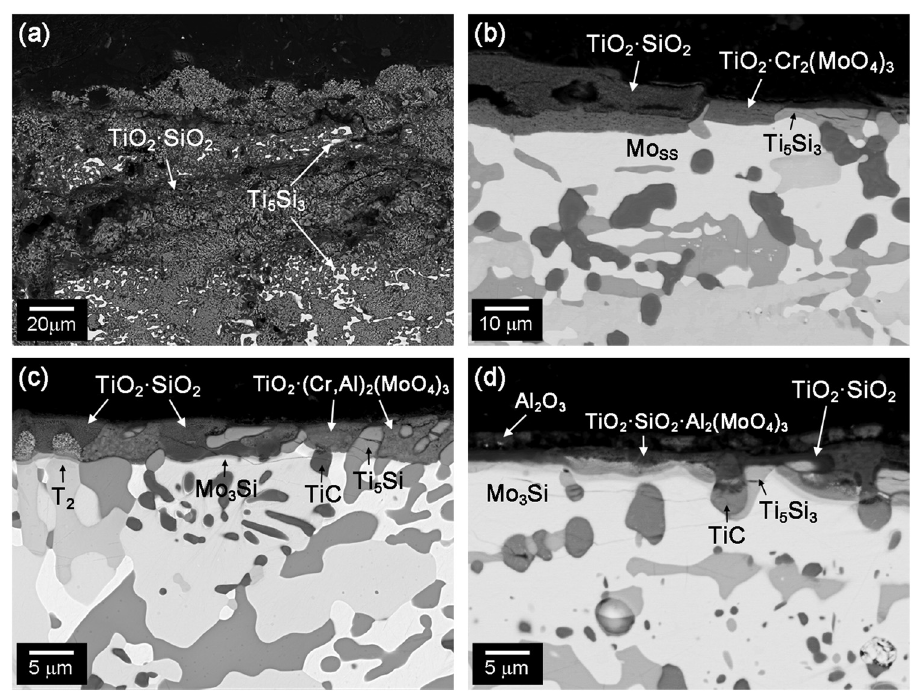
Figure 5: Cross - section microstructures of the ( a ) base, ( b ) 10Cr, ( c ) 5Cr5Al and ( d ) 10Al alloys oxidized at 800°C for 50